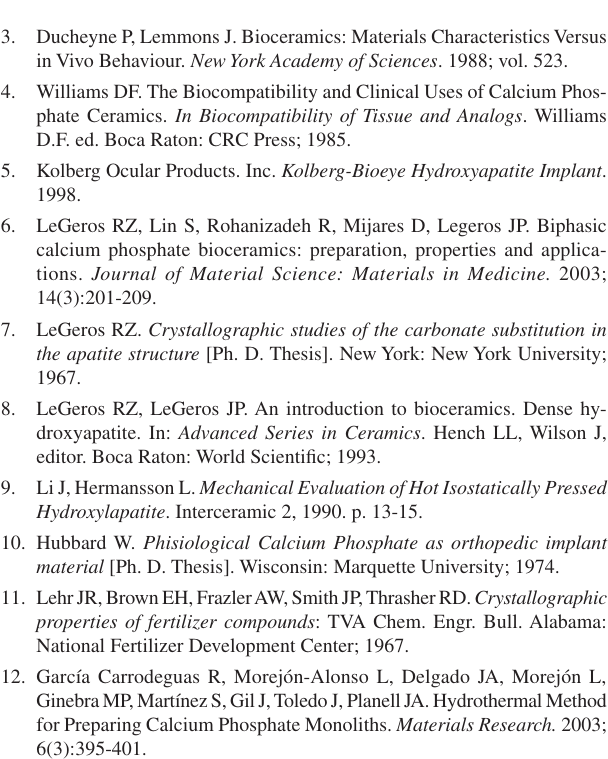
Figure 5. Compressive and diametral tensile strength of as obtained and sterilized material.